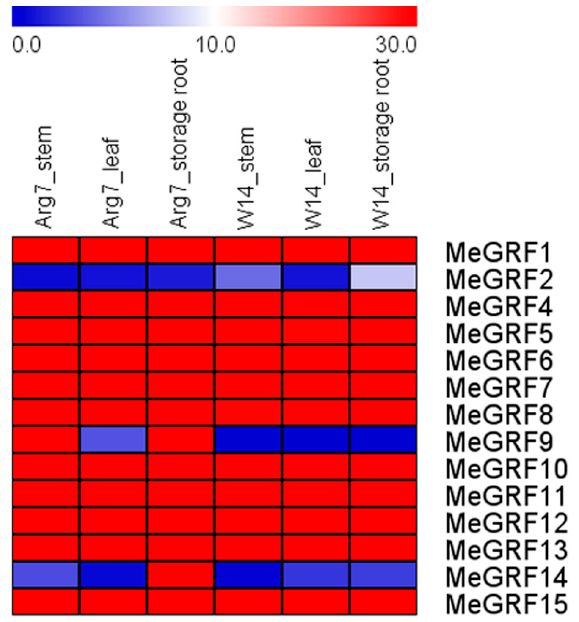
Figure 4. Expression analysis of cassava GRFs in stems, leaves, and storage roots of W14 and Arg7. The heat-map was created according to the Fragments per kilobase of transcript per million fragments mapped (FPKM) value of MeGRF s. Changes in gene expression are shown in color as the scale. 3.4. Differential Expression of MeGRF Genes in Response to Cold, Osmotic, Salt, ABA, and H 2 O 2 Treatments To investigate the transcriptional responses of MeGRF genes to abiotic stress and related signaling, cassava seedlings were subjected to cold, osmotic, salt, ABA, and H 2 O 2 treatments (Figures 5–9). Under cold treatment, MeGRF-4 , -6 , -7 , and -10 showed induction, whereas MeGRF-1 , -2 , -3 , and -5 showed repression. Under salt treatment, MeGRF-3 , -4 , -5 , -6 , -11 , -12 , and -13 were upregulated, while MeGRF-2 , -8 , -9 , -10 , -14 , and -15 were downregulated. Under osmotic treatment, MeGRF-3 , -5 , -6 , -10 , -11 , and -12 showed upregulation, whereas MeGRF-1 , -2 , -8 , -9 , -14 , and -15 showed downregulation. Under ABA treatment, MeGRF-3 , -4 , -5 , -6 , -11 , and -12 transcripts increased, whereas the transcripts of MeGRF-2 , -7 , -8 , -9 , -10 , -14 , and -15 decreased. Under H 2 O 2 treatment, MeGRF-2 , -4, -9 , and -10 were induced, whereas MeGRF-3 , -6 , -7 , -11 , -12 , and -13 were repressed. These results indicated that most of the MeGRF genes showed transcriptional changes under abiotic stress and related signaling molecule